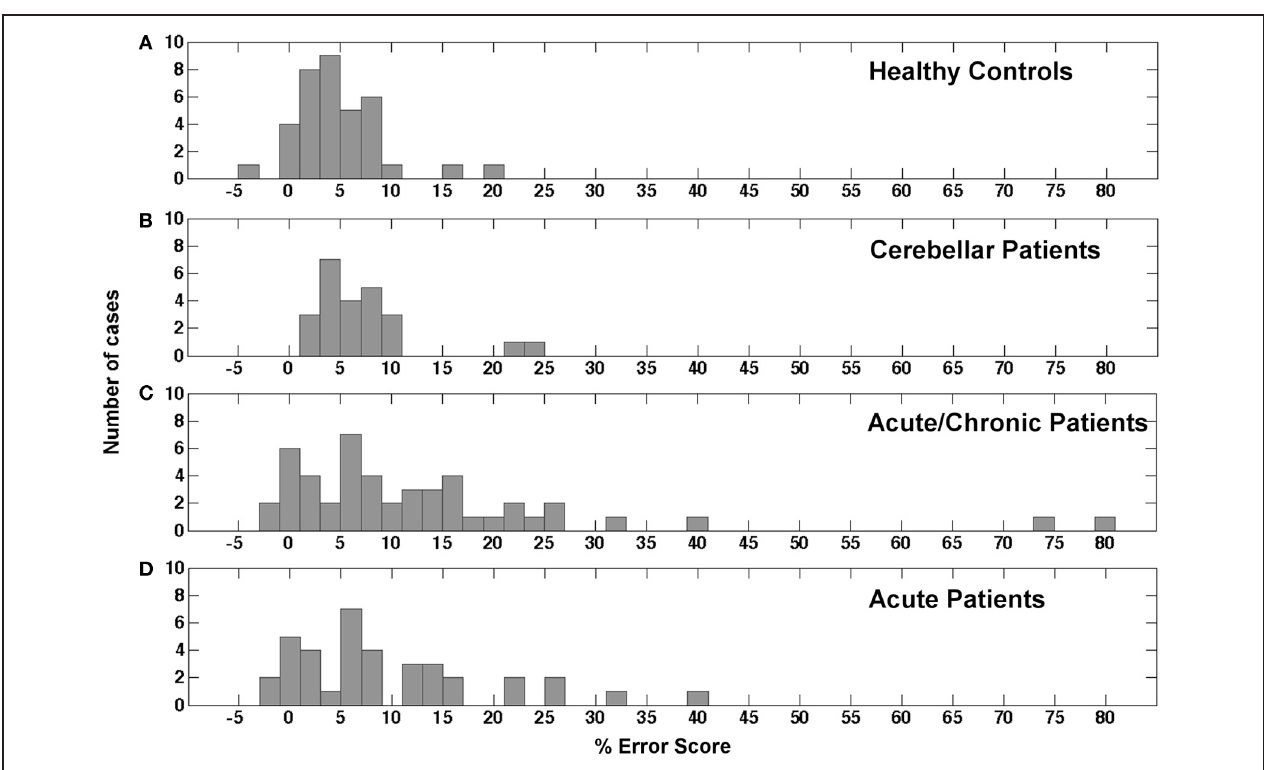
for the contralesional hand and contralesional field condition in acute and chronic stroke patients. (D) Error scores for the contralesional hand and contralesional field condition in acute stroke patients